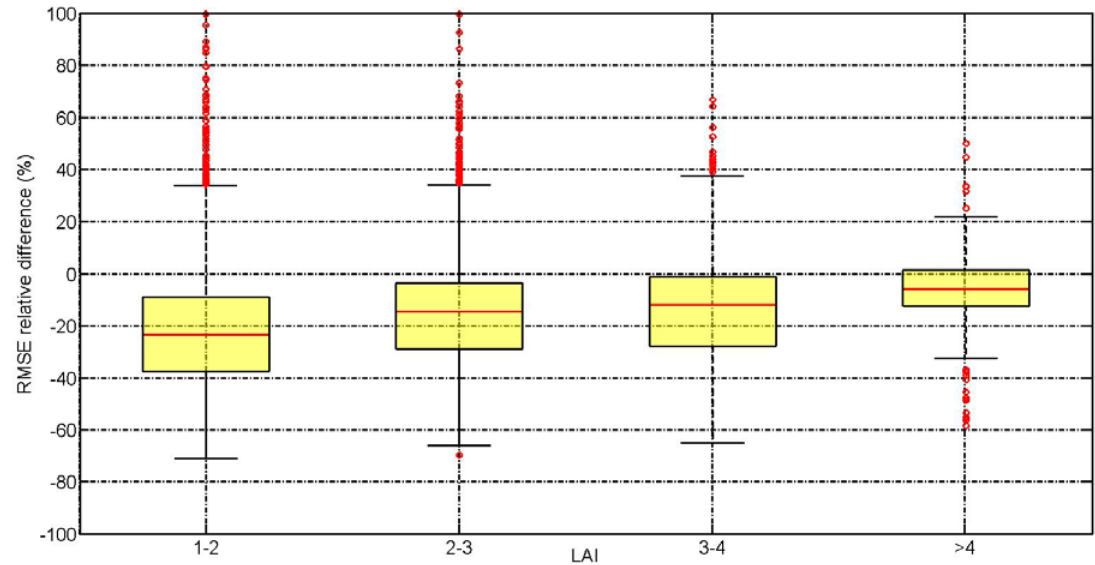
Figure 6. Box plot of relative difference in RMSE (%) between SMP and GPM (defined as 100% × (SMP − GPM)/GPM) with different ranges of LAI values.